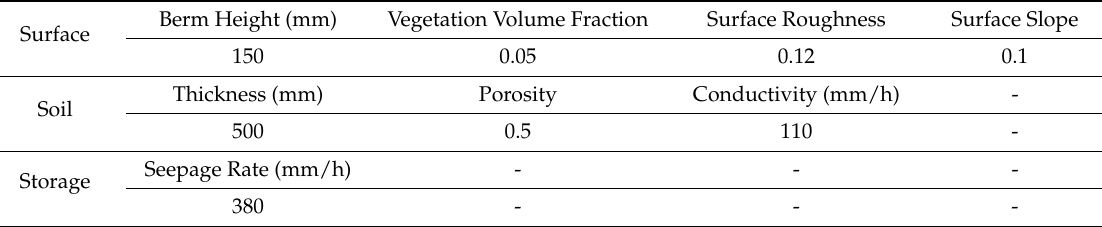
Table 4. Parameters of concave greenbelt in SWMM.